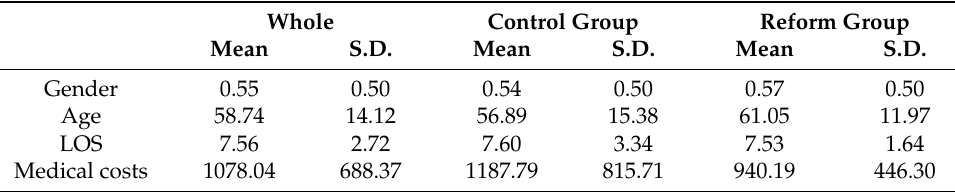
Table 1. Statistics